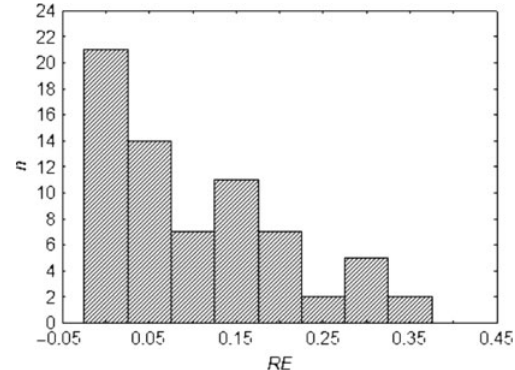
Fig. 16. Bar chart of relative error of pull-off adhesion f b and f c , b for neural network testing